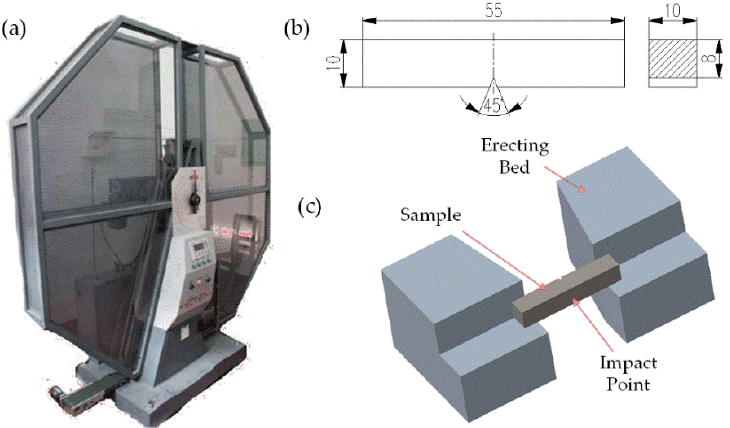
Figure 3. ( a ) Impact testing machine (ZBC2302-B). ( b ) Sample. ( c ) Impact sample installation dia-